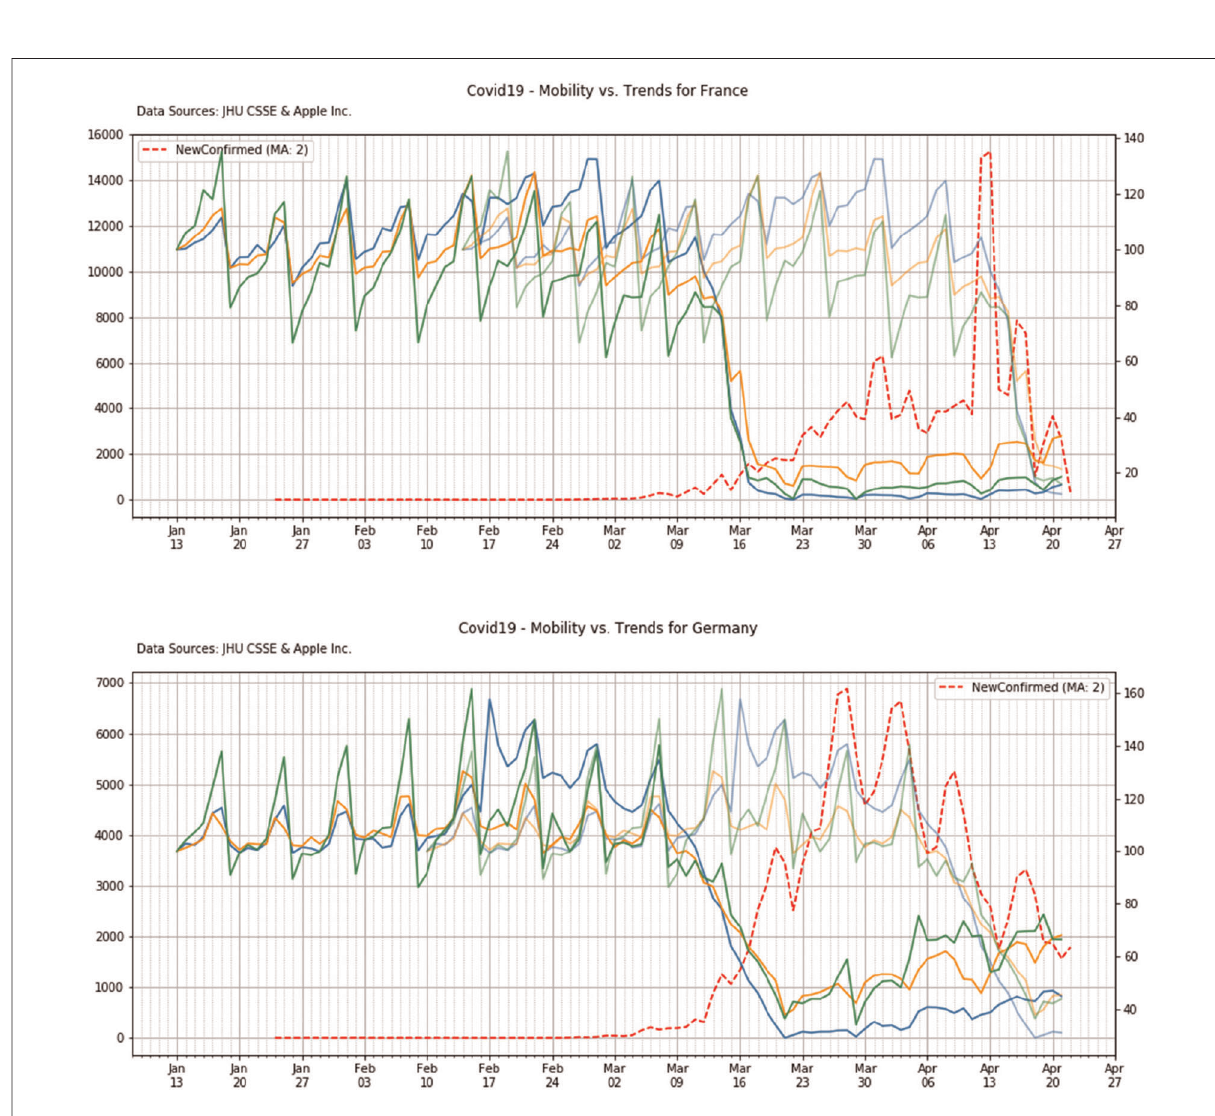
FIGURE 11 Mobility vs. COVID-19 trends of United Kingdom.